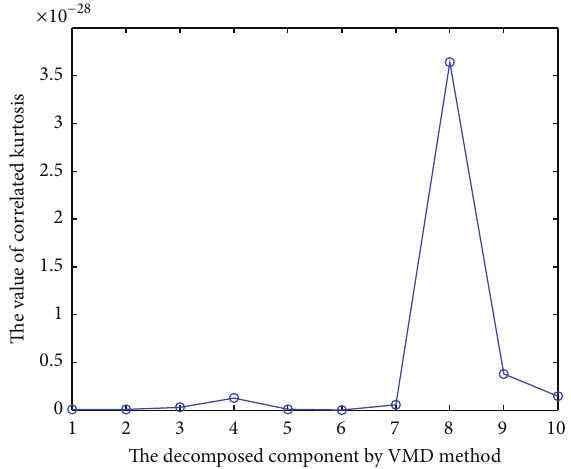
Figure 9: The correlated kurtosis of different